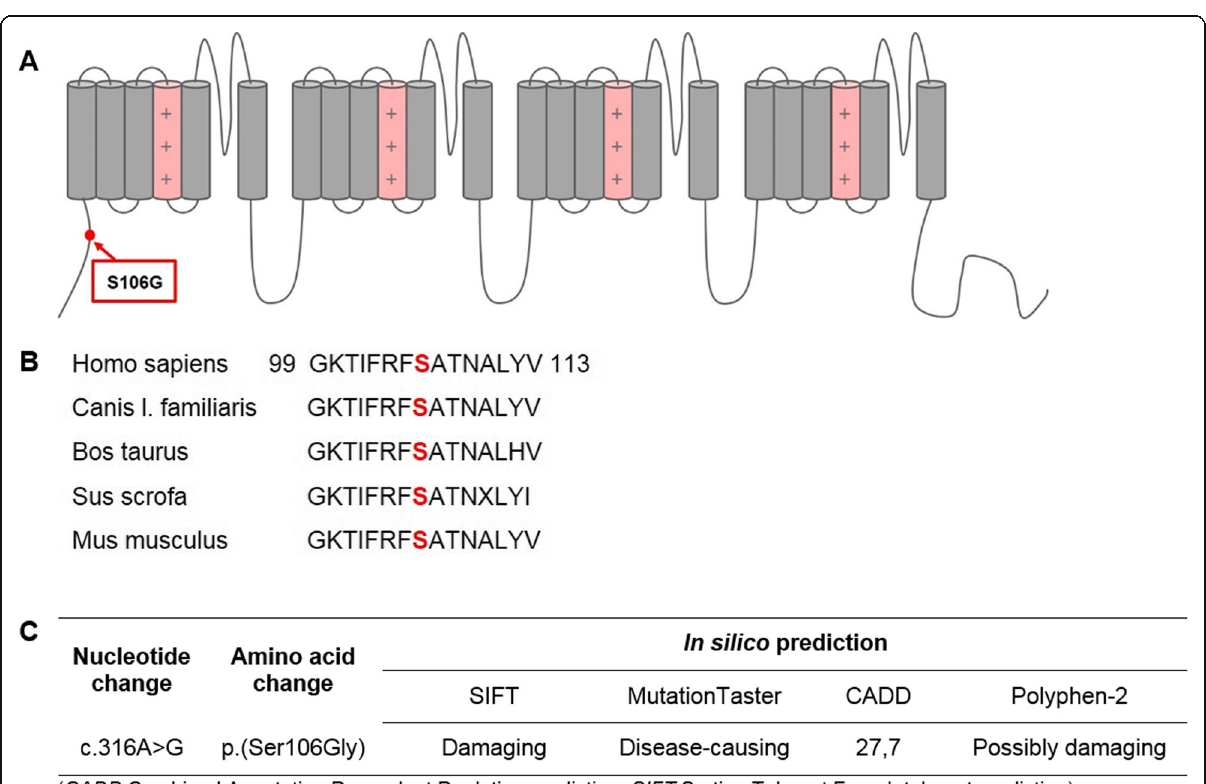
Fig. 1 Detection of the SCN5A variant p.(Ser106Gly) in a patient with aborted cardiac arrest. a Schematic representation of the Na v 1.5 channel and localization of the detected N-terminal variant. b Alignment of a partial N-terminal sequence among mammals. The affected amino acid is indicated in red. c Assessment of the genetic variant by in silico prediction